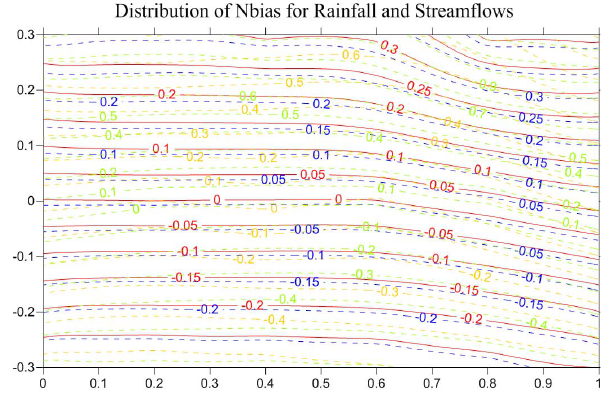
Fig. 5. Normalised bias distribution of perturbed rainfall and stream flow (red solid line: rainfall, orange dot line: MIKE SHE, green dot line: TOPMODEL, blue dot line: